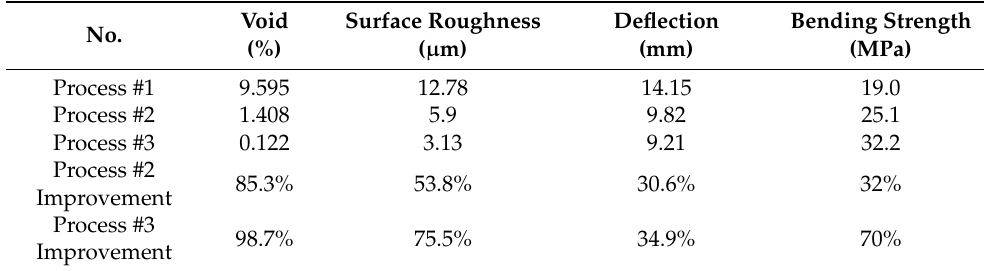
Table 7. Summary of physical property evaluation results.